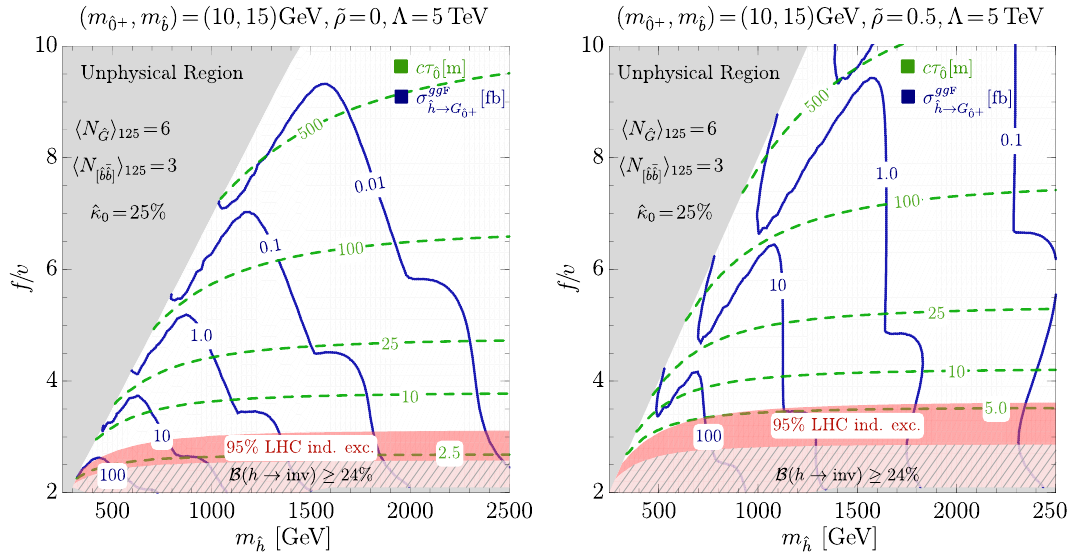
Figure 12 . These plots show parameter space in m ^ of heavy twin Higgs cross-section to twin glueball ^ G the glueball decay-length c(cid:28) ^0 (dashed green) are shown for ~ (cid:26) = 0 (left) and ~ (cid:26) = 0 : 5 (right). For 0 ++ twin glueballs with masses m of their production cross-sections (solid blue) and proper decay-lengths (dashed green) in m (cid:0) f=v plane in the left- and right-panel of (cid:12)gure 13, respectively. Whereas, ^ h